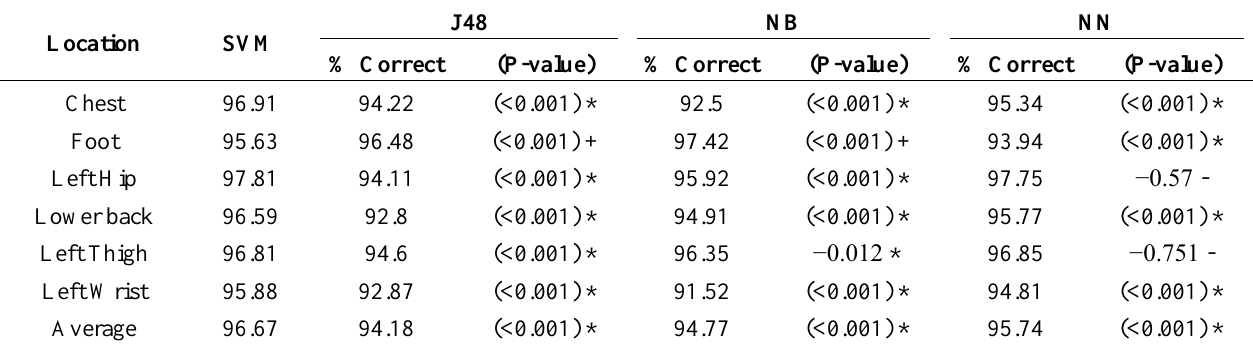
Table 4. Percentage of correctly classified instances for each location using each of the four machine learning algorithms. Results show the average percentage correctly classified instances for the 10 fold 10 iteration test. P-values are presented in brackets. (*) denotes significantly less than percentage correctly classified instances, (+) denotes significantly more than percentage correctly classified instances and (-) denotes no significant difference in percentage correctly classified instances. The average percentage accuracy for all locations is also